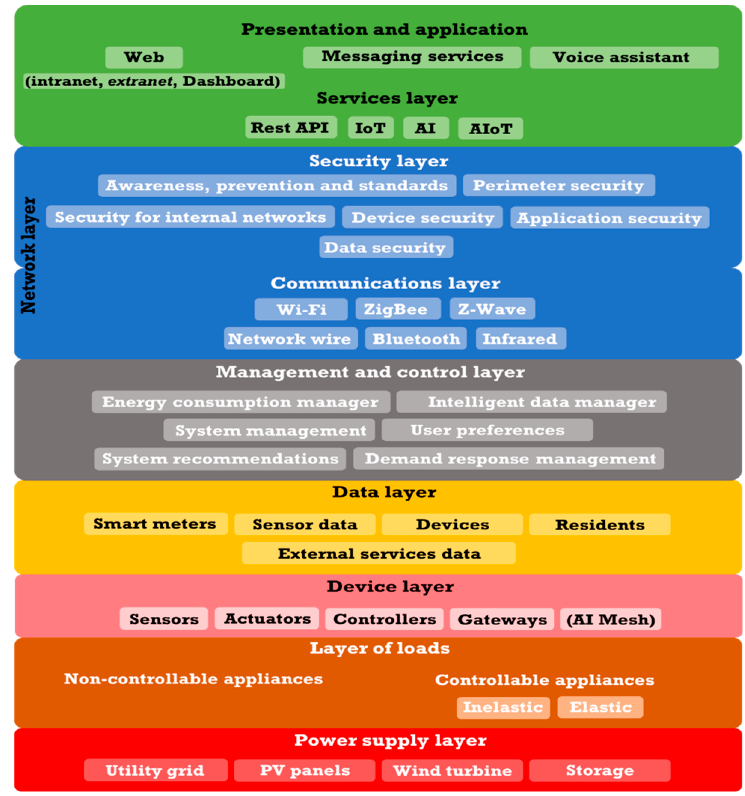
Figure 1. The generic architecture of a HEMS system.